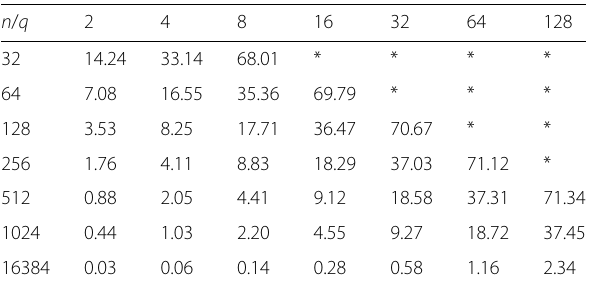
Table 1 Mean relative percentage errors between the normalized unbiased sample skewness ˜ γ s and the normalized unbiased skewness ˜ γ y for varying sample sizes n = 32, . . . , 16384, and overlapping return periods q = 2, . . . ,